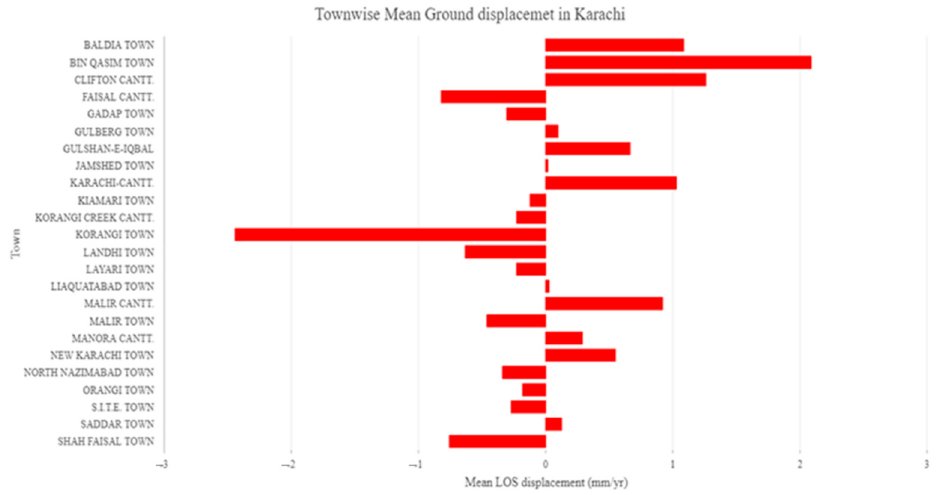
Figure 4. Town-wise mean ground displacements in Karachi.